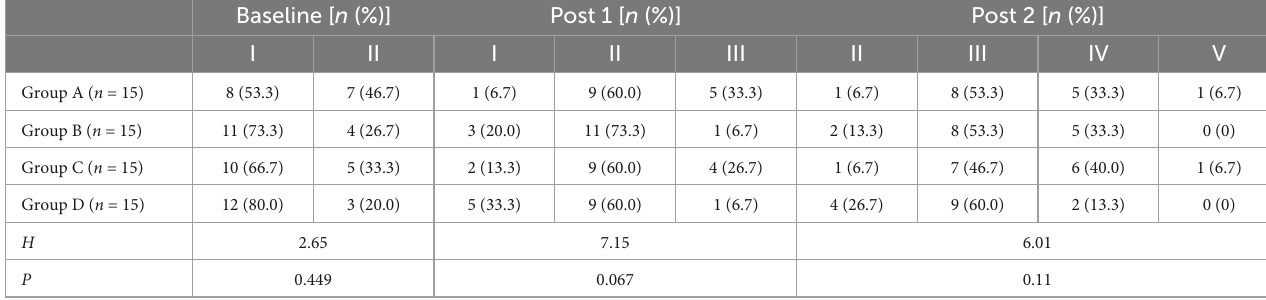
TABLE 7 Brunnstrom Stage of each